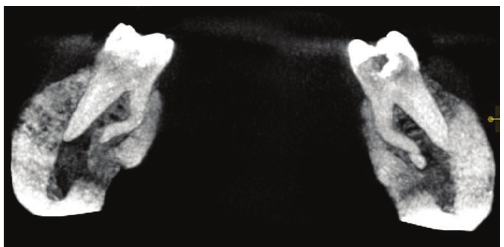
Figure 7: Coronal section showing 36 and